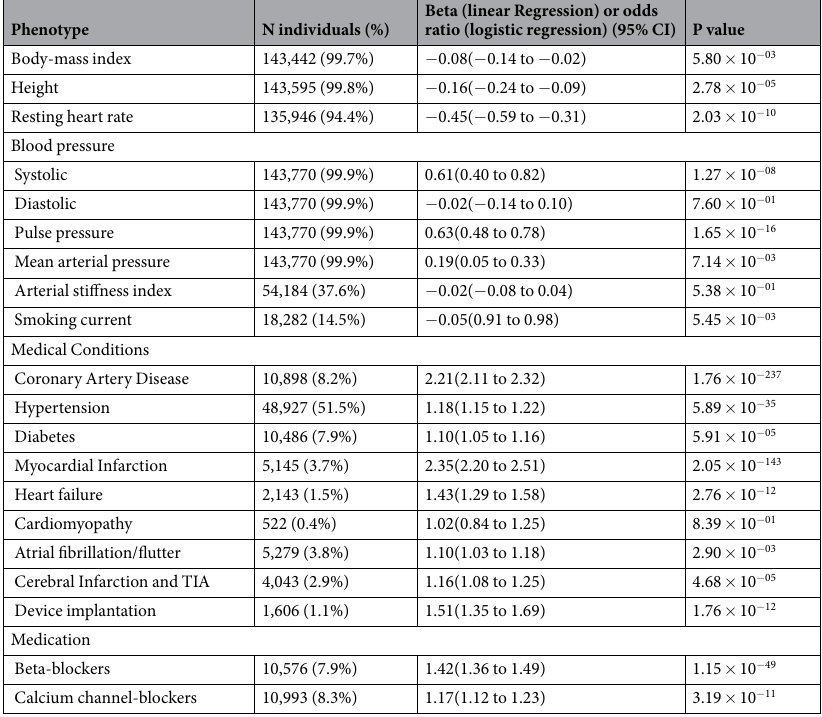
Table 2. Associations in UK Biobank (N = 143,936) between the genetic risk score based on the 71 genome wide significant CAD variants and cardiovascular profile. Effect estimates with 95% Confidence Interval (CI) are shown as odds ratios for categorical variables (current smoking, cardiovascular disease, atherosclerosis, hypercholesterolemia, hypertension, diabetes, myocardial infarction, heart failure, atrial fibrillation/flutter, cerebral Infarction and TIA, device implantation, beta-blockers and calcium-channel blockers) and β estimates for quantitative variables (body-mass index, resting heart rate, systolic and diastolic blood pressure, pulse pressure, mean arterial pressure and arterial stiffness index). Abbreviation: N = Number, CI = Confidence Interval, TIA = Transient Ischemic Attack.